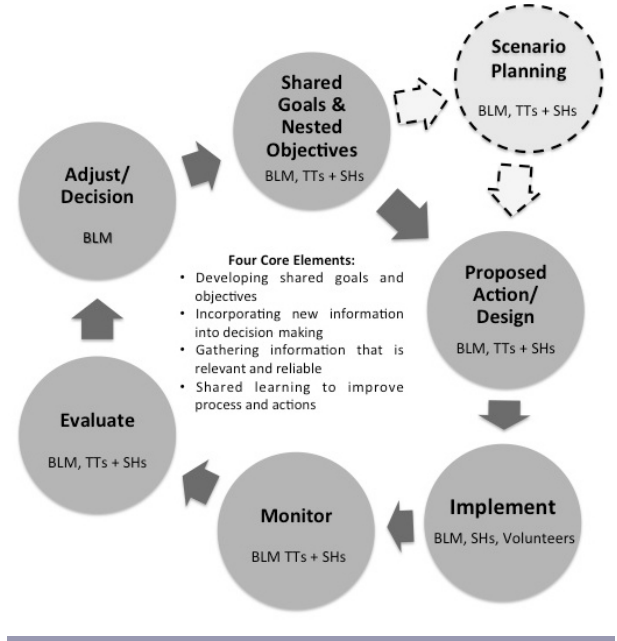
Fig. 3 . The collaborative adaptive management process at Las Cienegas National Conservation Area. At most stages of the cycle, stakeholders are actively involved through participation in the semiannual biological planning meetings, volunteering, or participation on a technical team (TT). The four core elements are essential for implementing this loop. We propose incorporating scenario planning as part of the CAM cycle, drawing upon the nested objectives to further refine the design of proposed actions. BLM = Bureau of Land Management; SH = Stakeholder. Note: the Permittee is considered a stakeholder and member of the